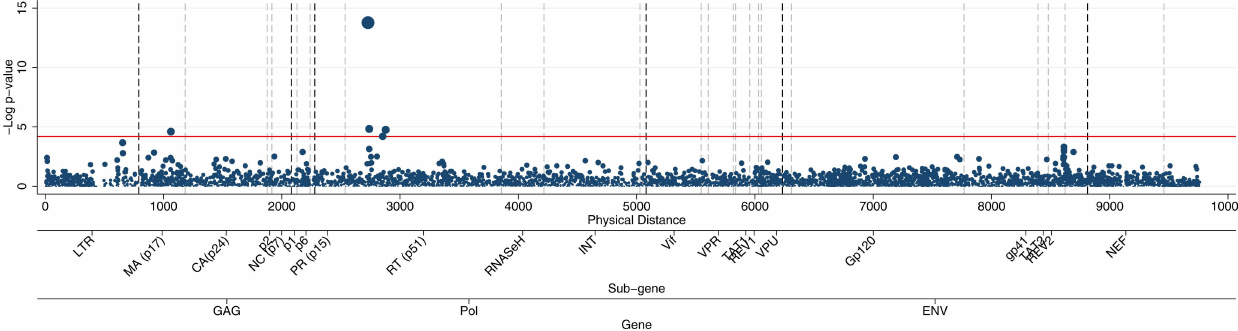
Fig 2. Manhattan plot comparing HIV sequences that were exposed to tenofovir to those that were not. The reference line at p = 7E-5 is the line for permutation adjusted genomewide significance. Dashed grey lines on genomic locationsrefer to borders of genes (black dashed refer to GAG, Pol and ENV). Each marker is a SNP, weighted by it’s—log(p-value) to highlight the most significant SNPs.